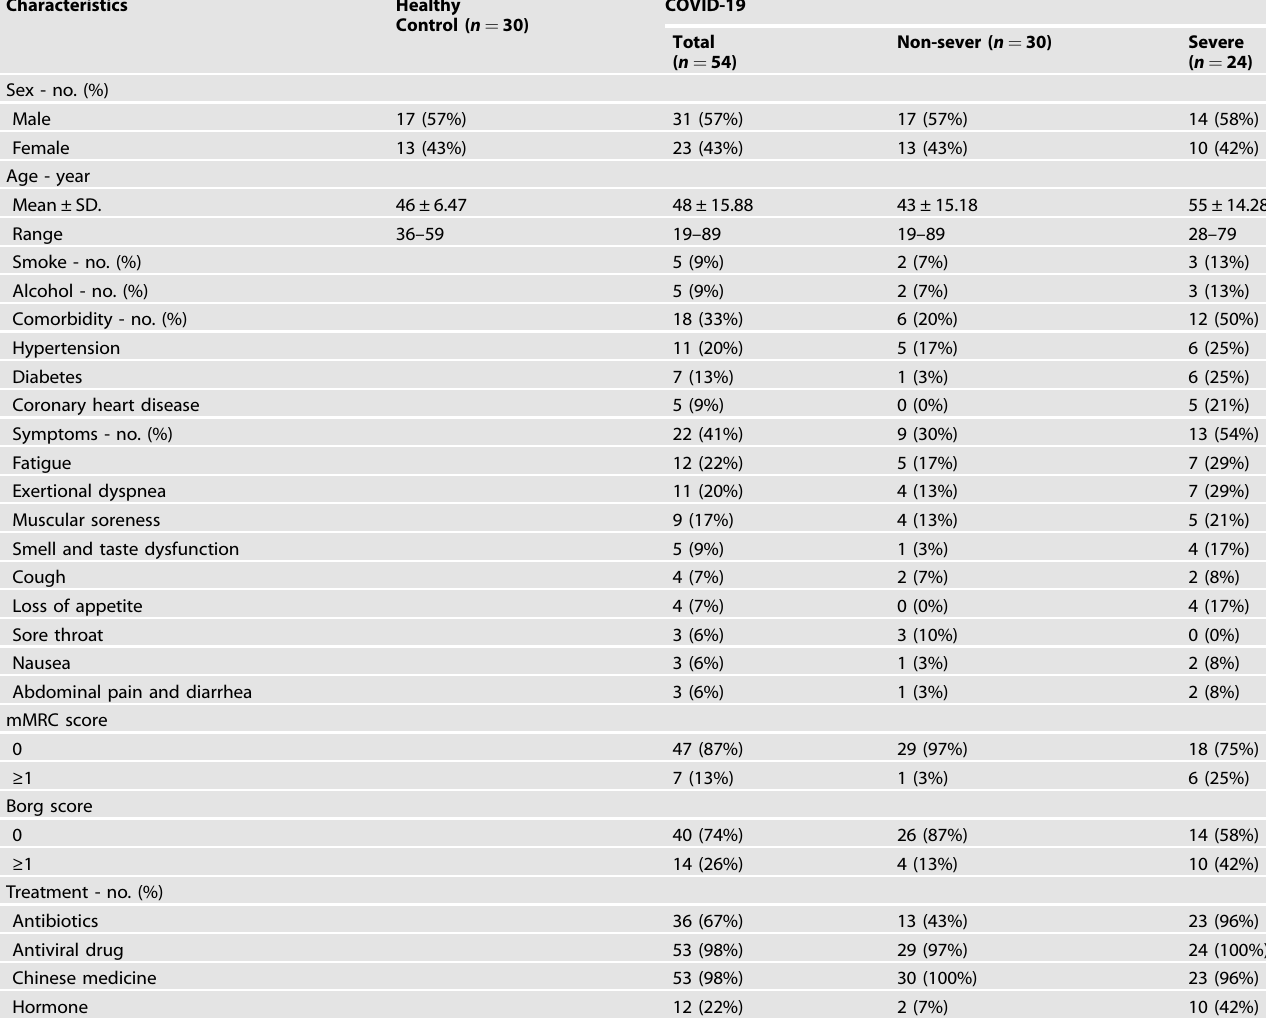
Table 1. Demographics and Clinical Characteristics of COVID-19 Patients 6 months after discharge and Healthy Control.